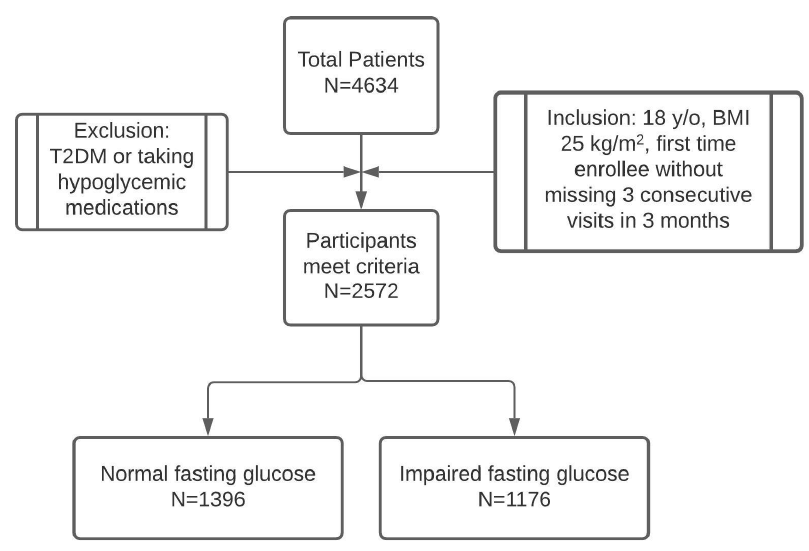
Figure 1. Patient chart review included in the study analysis. Table 1. Demographic Information.